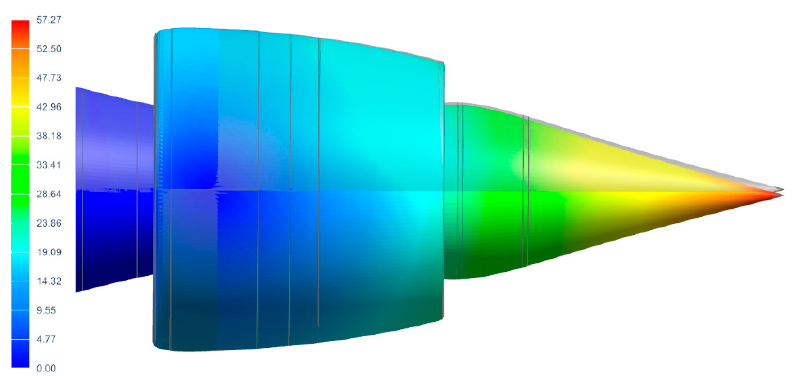
Figure 25. Displacement map for aft-fuselage nacelle and integration structure of PFC Rev07 design case 2 under CS 25.561 loads. Color legend shows vertical displacement in mm. Table 8. Overview of fuselage and FF integration structural weight results.